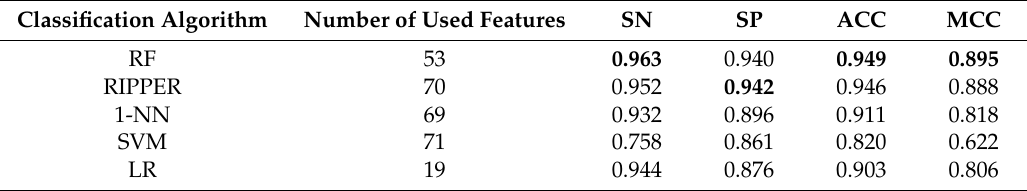
Figure 2. IFS curves based on the predicted results yielded by the IFS method with five different classification algorithms. The X-axis represents the number of features participating in the classification, and the Y-axis represents the Matthew’s correlation coefficients ( MCC s). The optimal MCC (marked with red diamonds) for random forest (RF), repeated incremental pruning to produce error reduction (RIPPER), nearest neighbor algorithm (1-NN), support vector machine (SVM) and logistic regression (LR) is 0.895, 0.888, 0.818, 0.622 and 0.806, respectively. For RF, when top 13 features were used, the MCC value first overcomes 0.880. While for RIPPER, the MCC value first achieves 0.870 when top 10 features were employed. Table 1. Performance of the optimal random forest (RF), repeated incremental pruning to produce error reduction (RIPPER), nearest neighbor algorithm (1-NN), support vector machine (SVM), and logistic regression (LR) classifier.